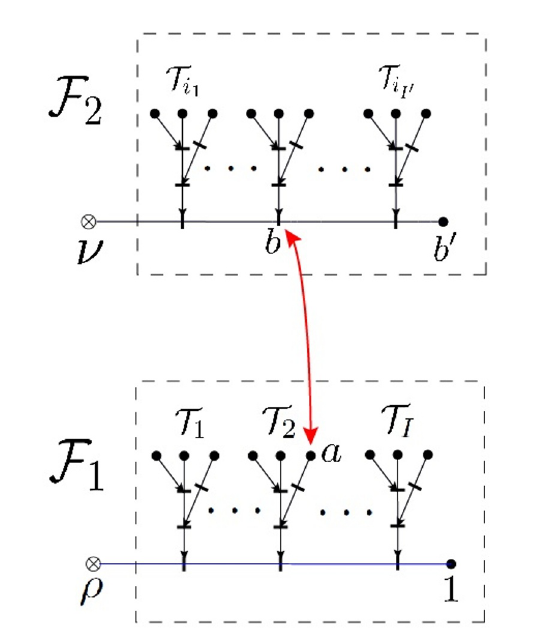
Figure 21 . Suppose b 0 is the highest-weight node in F 2 . Any a ∈ F 1 and b ∈ F 2 are connected through the red line (the 2 k · 2 k line). The chain colored blue is the master chain of F corresponds to a term in eq.